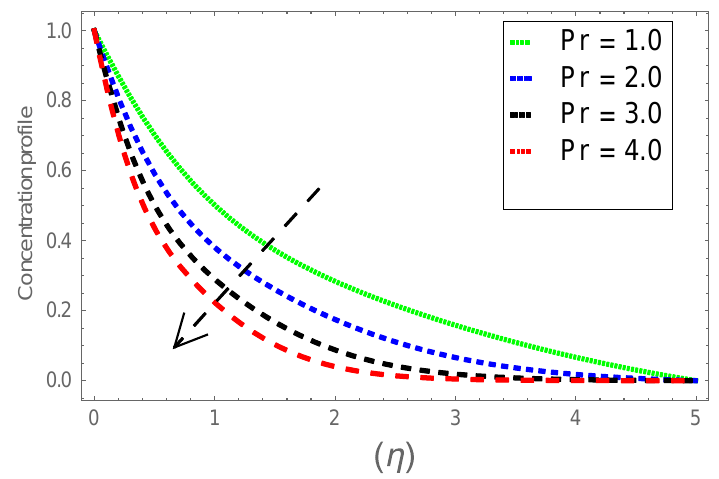
   Figure 26. Consequence of ( Pr ) via φ ( η ) .